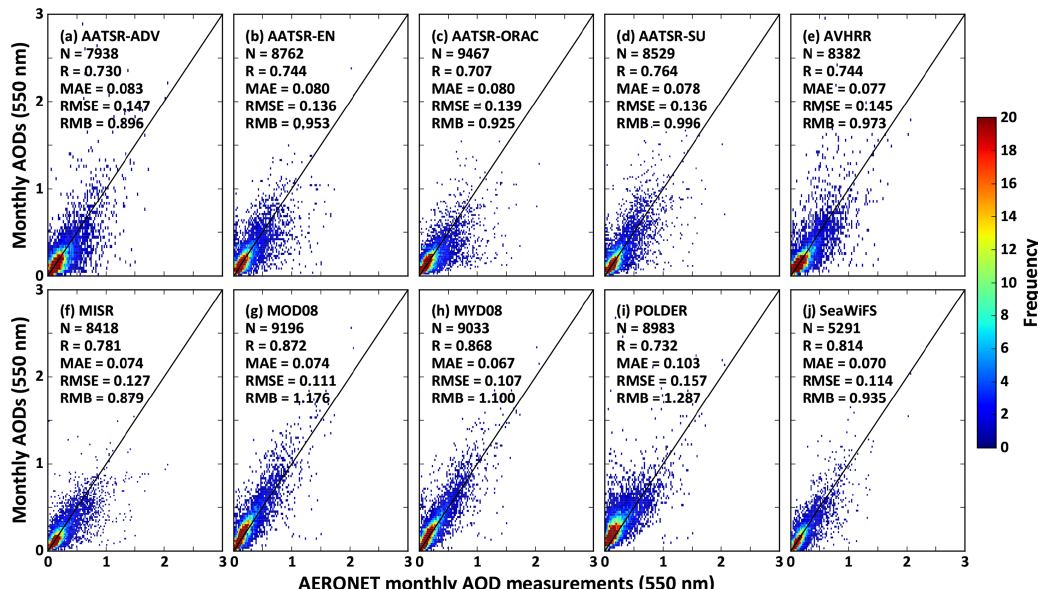
Figure 2. Density scatter plots of the monthly averages of satellite-derived AOD S vs. AERONET AOD A throughout the world.